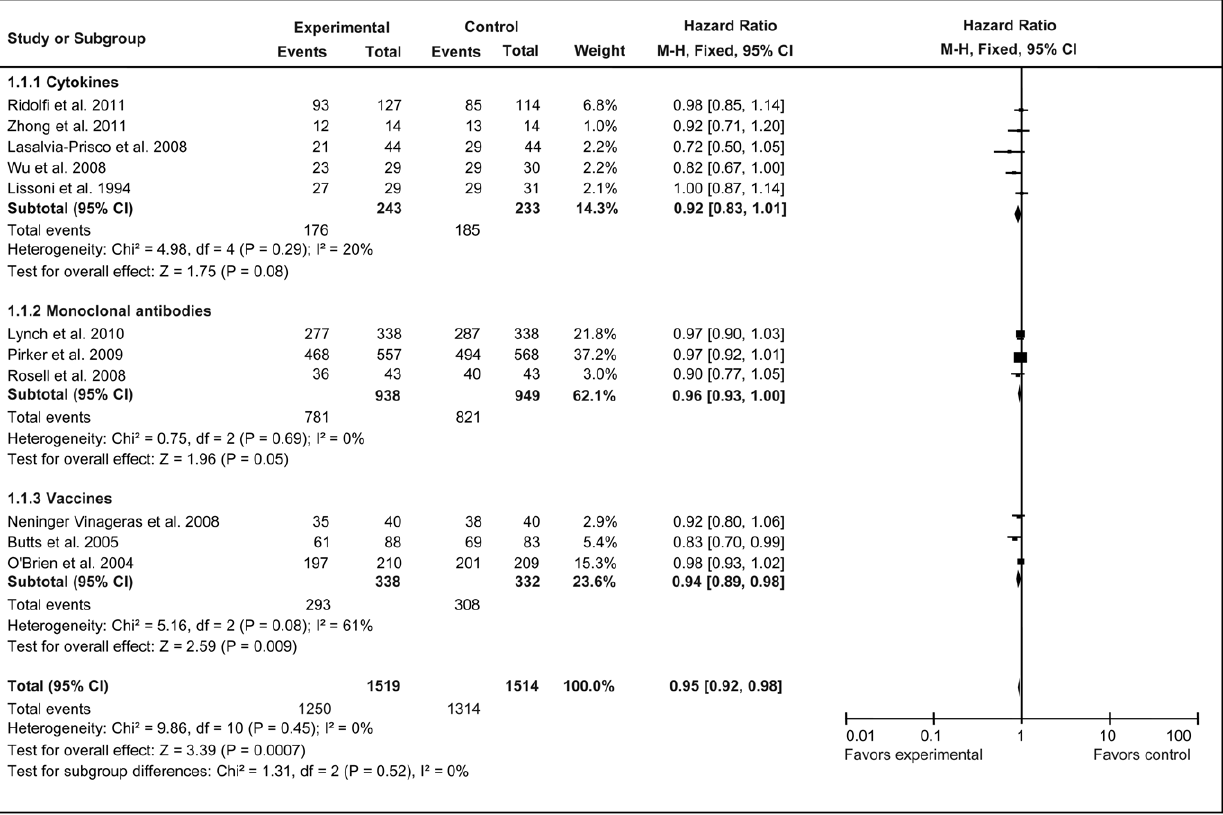
Figure 2. Forest plot of comparison of overall survival of 11 included studies (Stage IIIA, IIIB, or IV NSCLC). P values are from P-for- effect modification testing for heterogeneity within or across the groups of regimens. The sizes of data markers are proportional to the number of deaths in the trials. CI, confidence interval; HR, hazard ratio. doi:10.1371/journal.pone.0032695.g002 PLoS ONE |